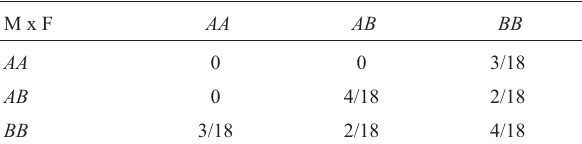
Table 5 - Mating scheme with q = 1/3, F = 1/4, G = -1/4, s = 1/18 and t =